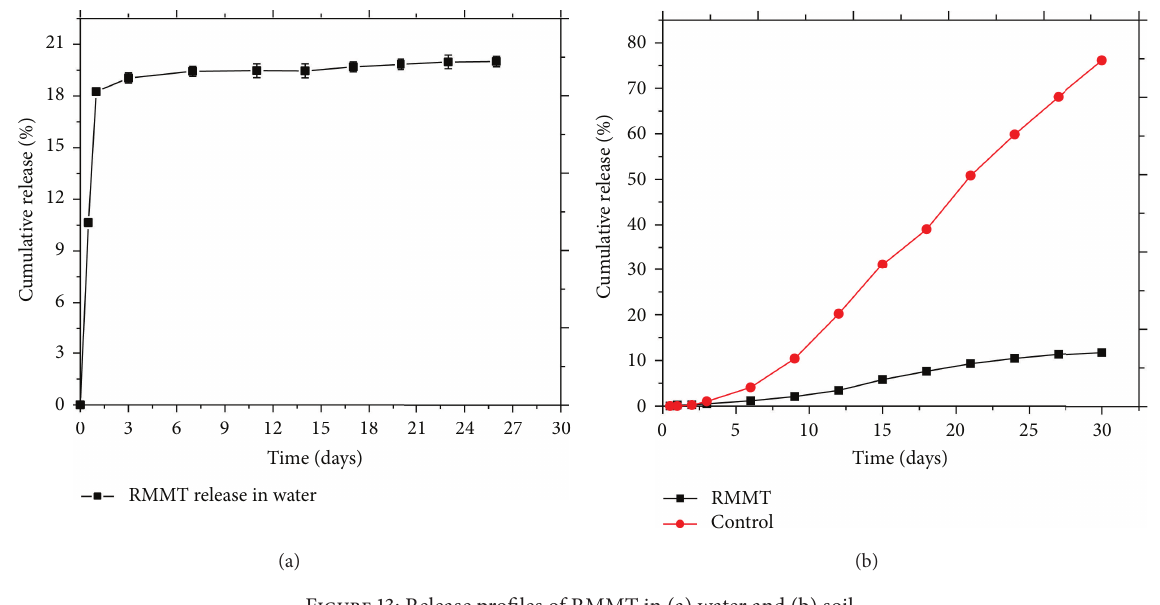
Figure 13: Release profiles of RMMT in (a) water and (b)